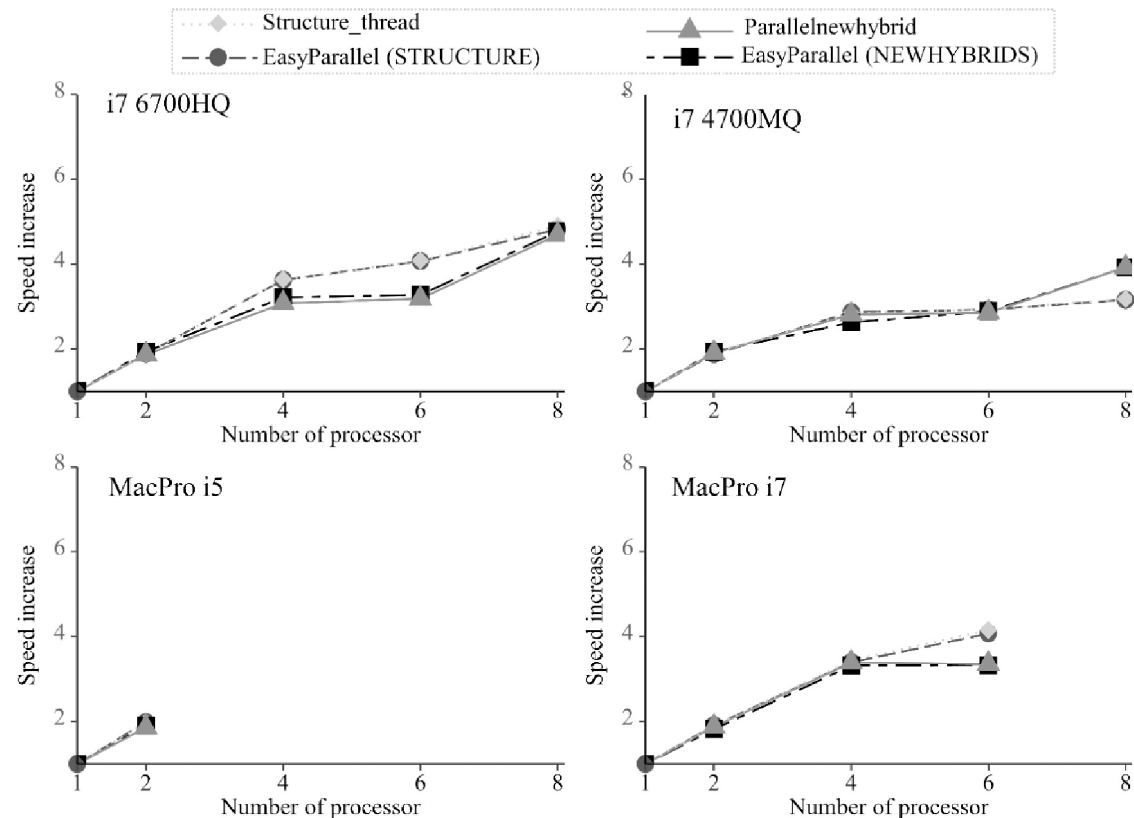
Fig 2. Speed gain obtained by parallelization in EasyParallel and its comparison with Structure_threader and Parallelnewhybrid. The speed increase was calculated by dividing the execution time on a single thread (sequential run) by the execution time obtained from different number of threads. i7 4700MQ – Lenovo Y510, Windows 10, 2.4 GHz Intel Core i7- 4700MQ with 8 GB RAM and 4 physical cores (8 logical threads); i7 6700HQ – Lenovo Y700, Windows 10, 2.6 GHz Intel Core i7-6700HQ with 8 GB RAM and 4 physical cores (8 logical threads); MacPro i5 – MacBook Pro, OS 10.14, 2.7 GHz Intel Core i5 with 16 GB RAM and 2 physical cores; MacPro i7 – MacBook Pro, OS 10.14, 2.6 GHz Intel Core i7 with 16 GB RAM and 6 physical